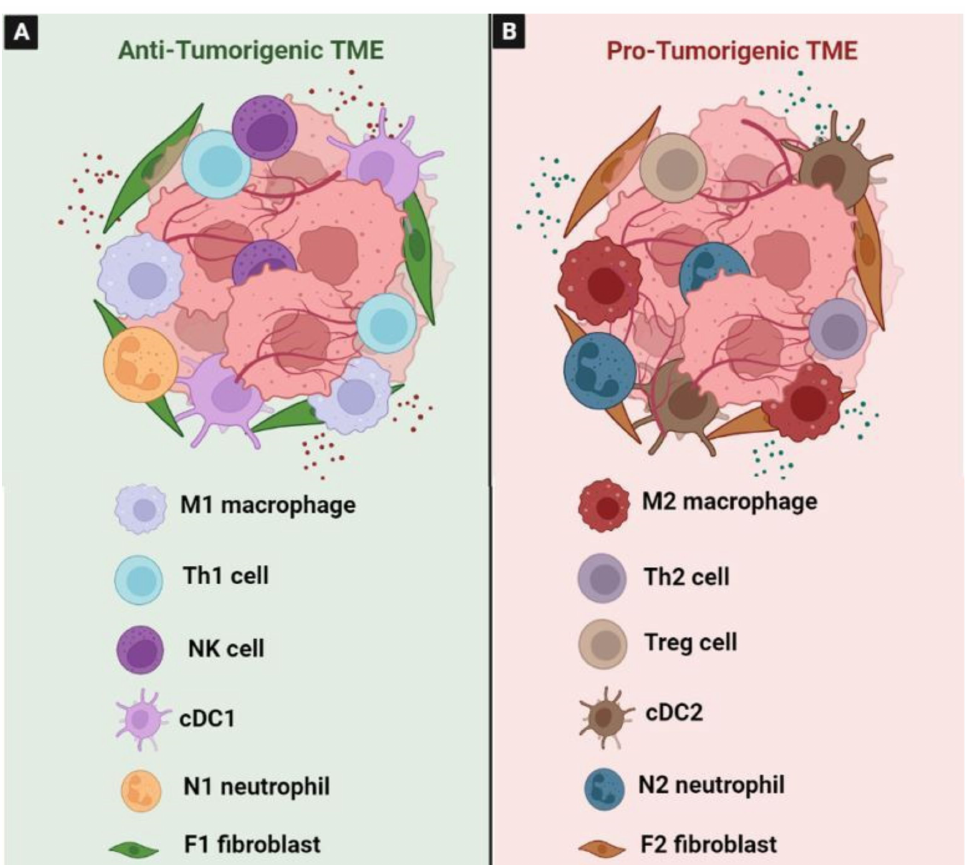
Figure 11. The anti-tumorigenic and the pro-tumorigenic effects of the TME components: ( A ) The anti-tumorigenic TME is characterized by the presence of cells that possess anti-tumor functions: M1 macrophages, Th1 cells, NK cells, cDC1, N1 neutrophils and F1 fibroblasts. ( B ) On the other hand, the pro-tumorigenic TME is composed mainly of cells, which have a pro-tumor effect: M2 macrophages, Th2 cells, Treg cells, cDC2, N2 neutrophils and F2 fibroblasts. Abbreviations: TME: Tumor Microenvironment, Th: T helper, NK: natural killer, cDC: Conventional Dendritic cell, Treg: T